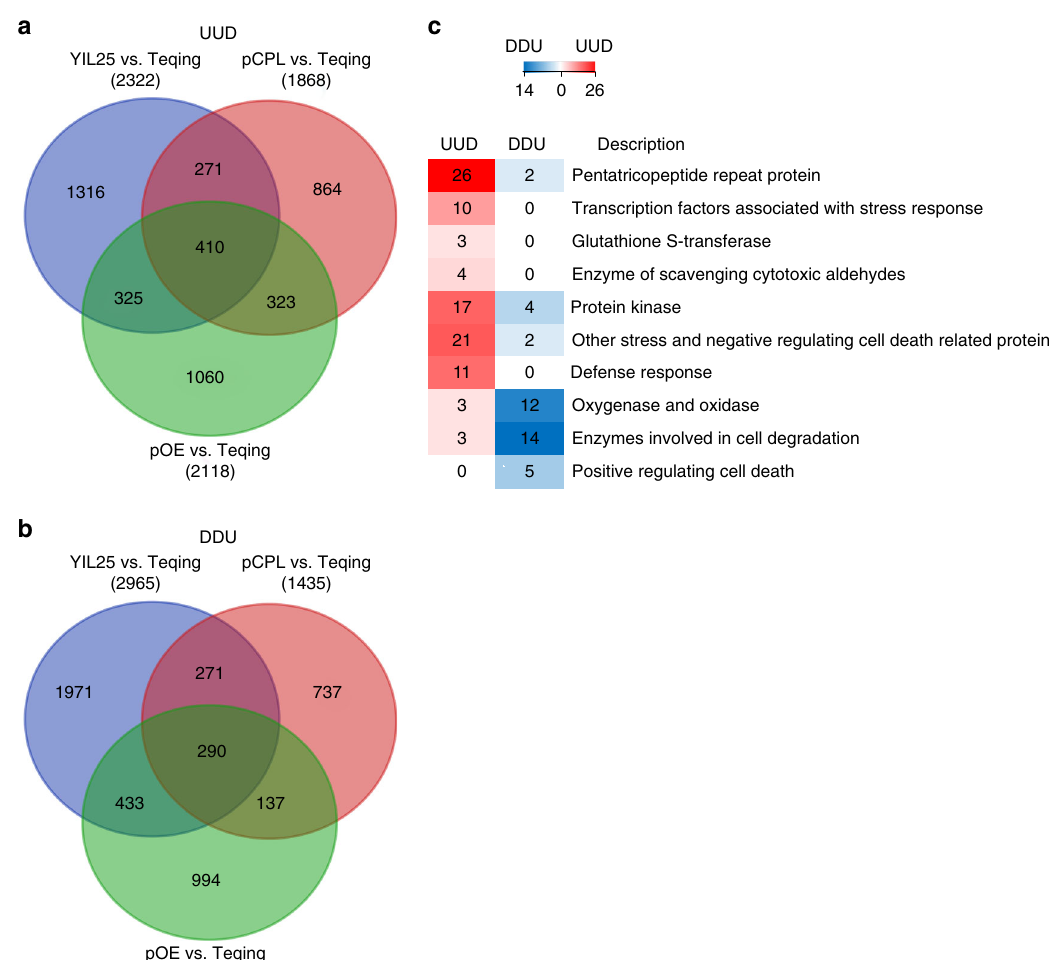
Fig. 7 Differentially expressed genes in YIL25, the complementation line, overexpression line, and Teqing revealed by RNA-seq analysis. a Hierarchical clustering of 410 differentially expressed genes (DEGs) upregulated in YIL25 compared to Teqing, DEGs upregulated in the complementation line (pCPL) compared to Teqing, and DEGs downregulated in the overexpression line (pOE) compared to Teqing (UUD). b Hierarchical clustering of 290 DEGs downregulated in YIL25 compared to Teqing, DEGs downregulated in pCPL compared to Teqing, and DEGs upregulated in pOE compared to Teqing (DDU). c Hierarchical clustering of DEGs associated with stress response and cell death. The numbers in the boxes represent the number of genes per